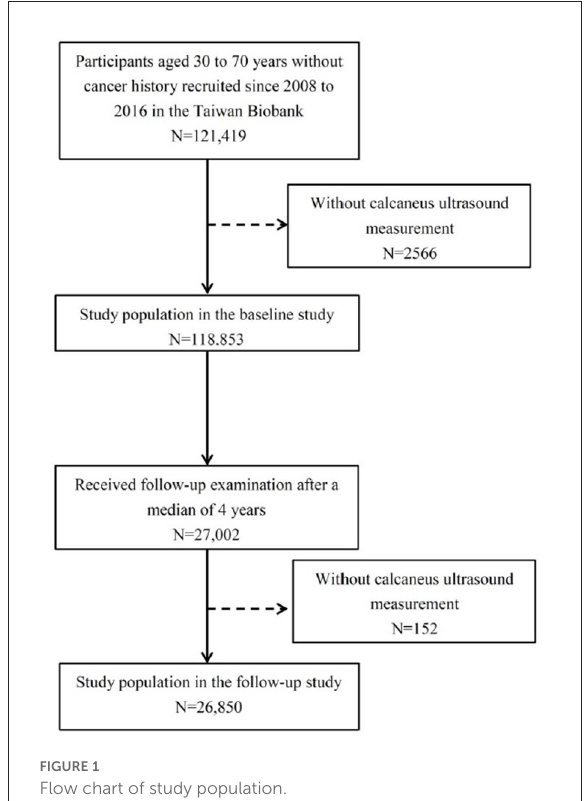
FIGURE1 Flow chart of study